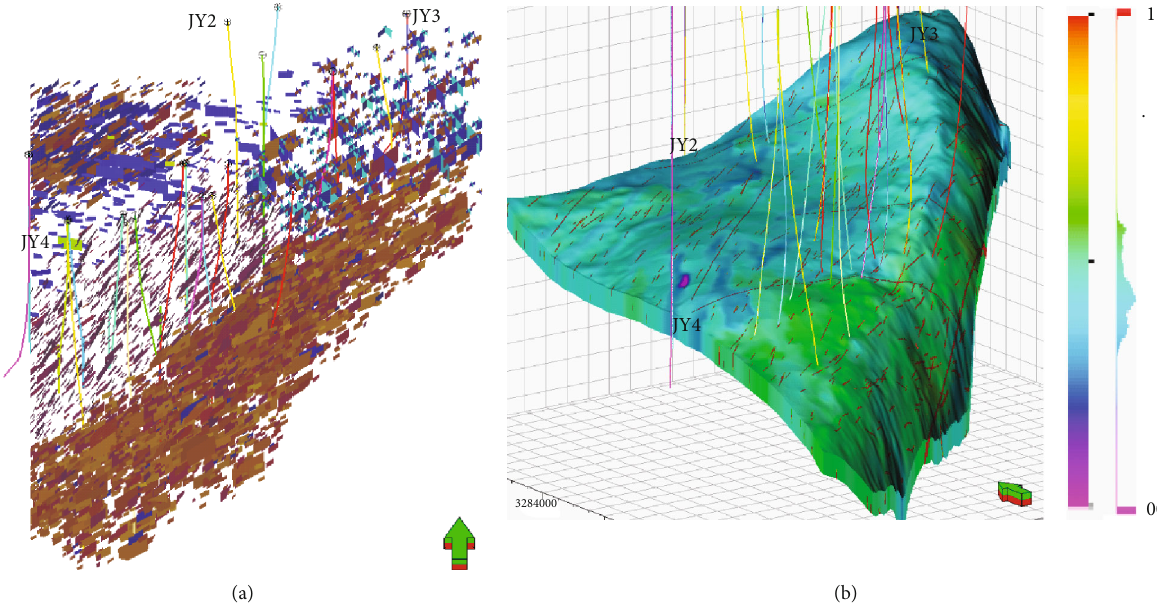
Figure 15: Natural fracture model in the Fuling shale gas fi eld. (a) The discrete fracture network (DFN) model of medium-scale natural fractures controlled by fracture facies in the study area. (b) Fracture permeability model controlled by fracture facies.